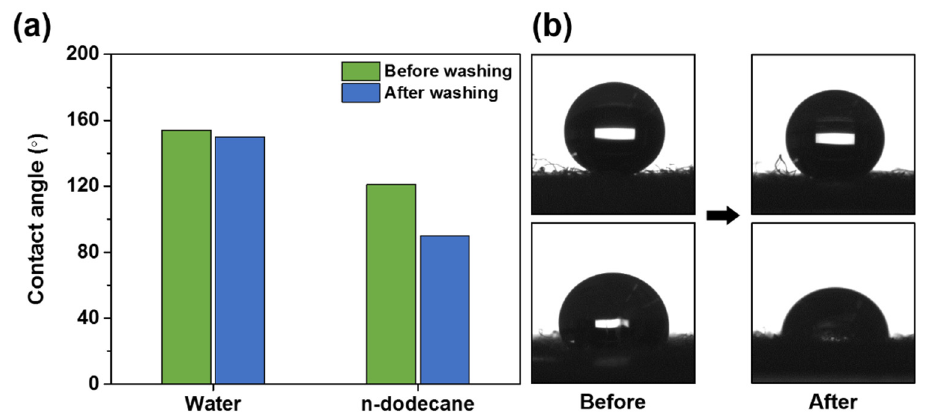
Figure 8. The contact angles ( a ) and captured images ( b ) of water droplet ( top ) and n-dodecane droplet ( bottom ) on OmniBlock-coated cotton fabric after washing treatment.